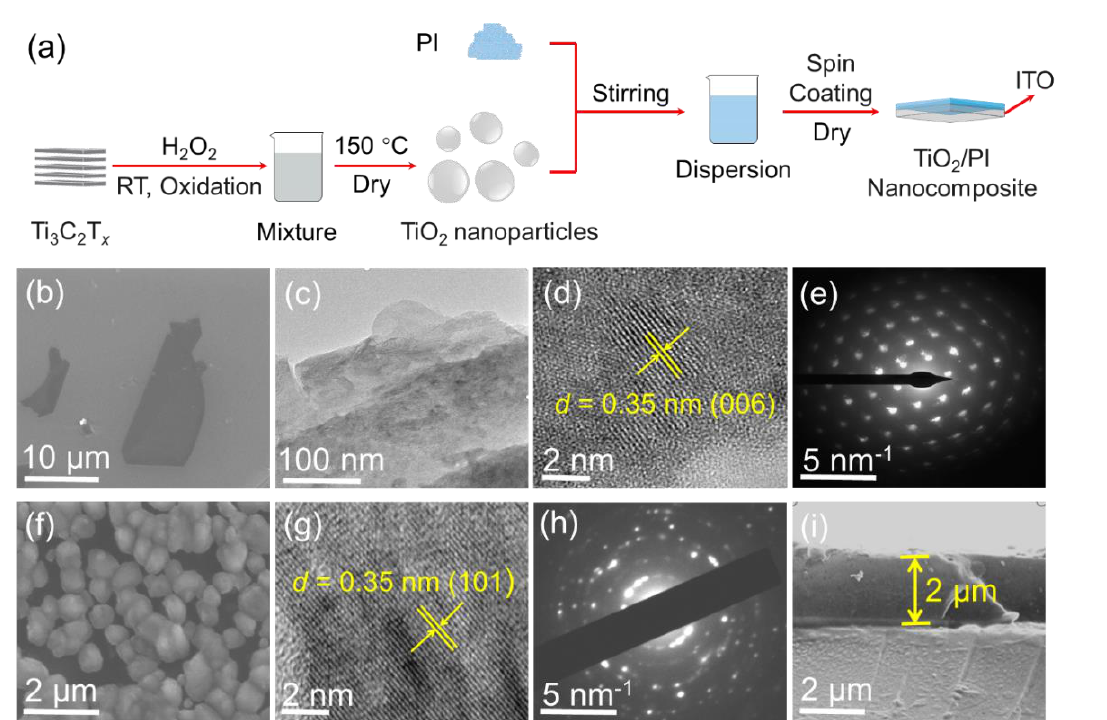
Figure 1. Preparation of TiO 2 /PI nanocomposites. ( a ) Process schematics for the preparation of TiO 2 /PI nanocomposites. ( b ) SEM image, ( c ) low-magnification TEM image, ( d ) high-magnification TEM image, and ( e ) SAED pattern of Ti 3 C 2 T x . ( f ) SEM image, ( g ) high-magnification TEM image, and ( h ) SAED pattern of TiO 2 nanoparticles. ( i ) Cross-sectional S EM image of TiO 2 /PI nanocomposite.